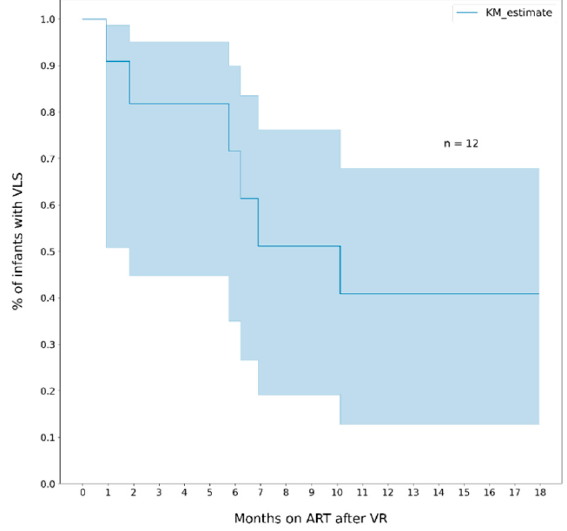
Figure 3. Cumulative probability of viral rebound (VL > 1000 cp/mL) among infants who reached